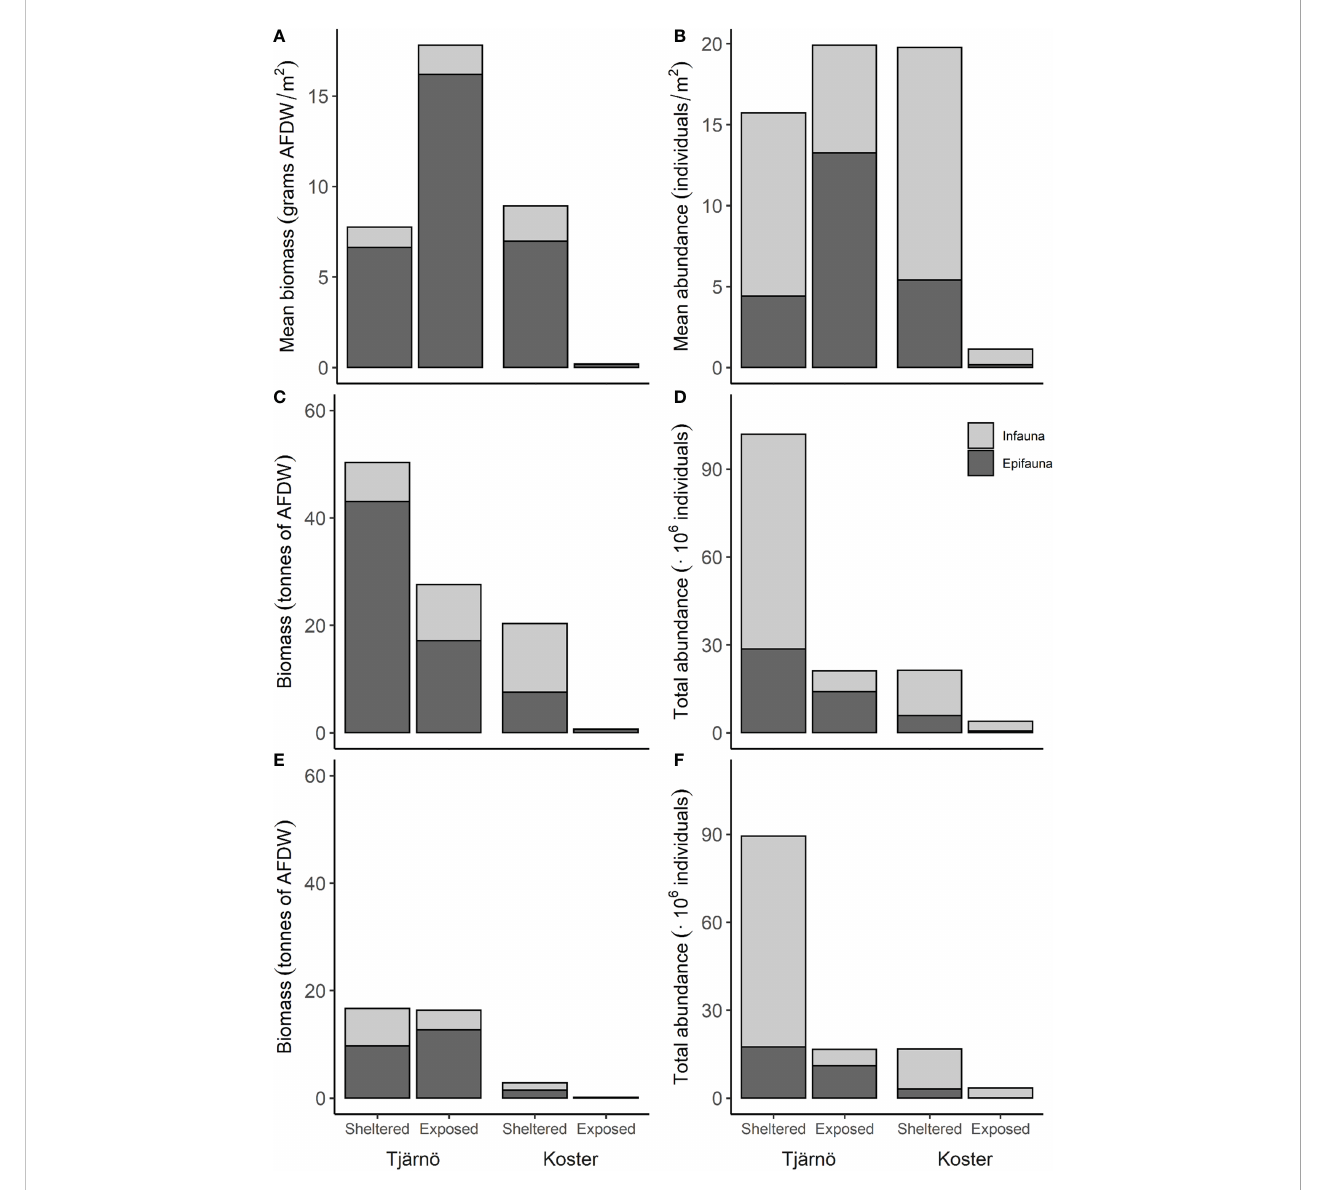
FIGURE 5 Total biomass (AFDW) and total abundance of epi- and infauna in sheltered and exposed parts of Tjärnö and Koster areas. The fi rst row show biomass (A) and abundance (B) per m2 accounting for habitat availability, and the second row show the totals accounting also for areal extent (C, D) . The third row show total biomass (E) and abundance (F) for each area excluding the two invasive species, Magallana gigas and Ensis leei . See text and Table S1 for details about calculations and